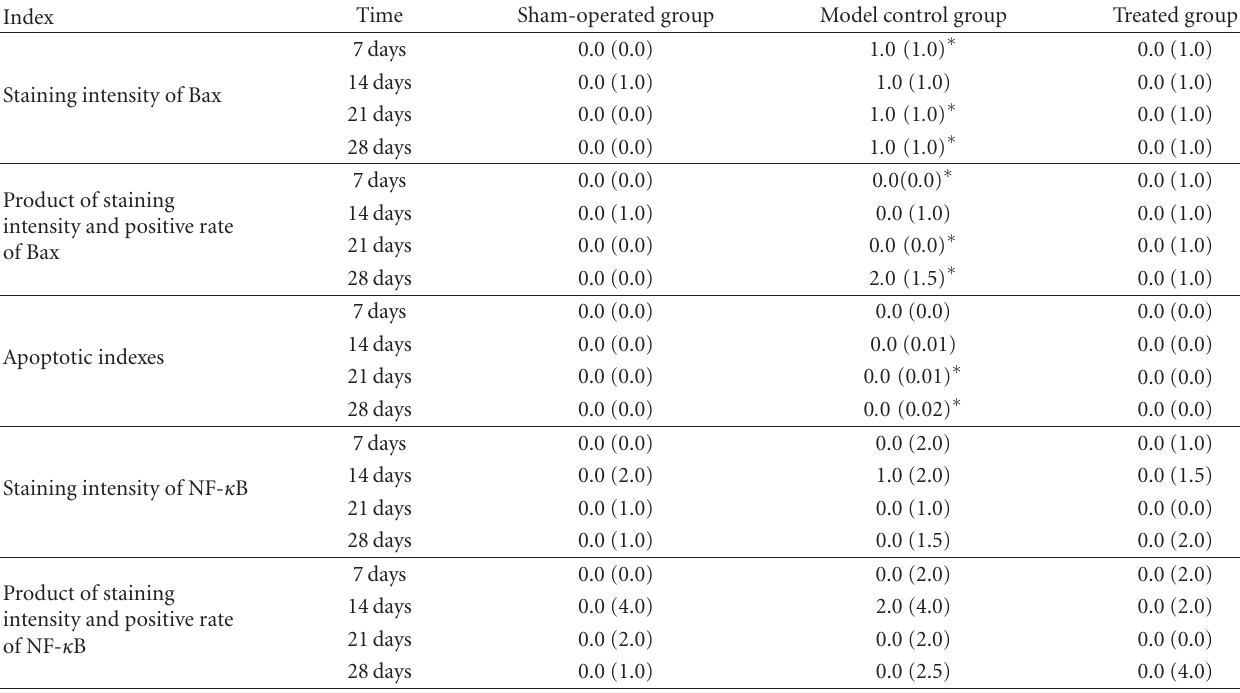
Table 8: Comparison of pathological indexes of thymus in OJ groups ( M ( Q R )).